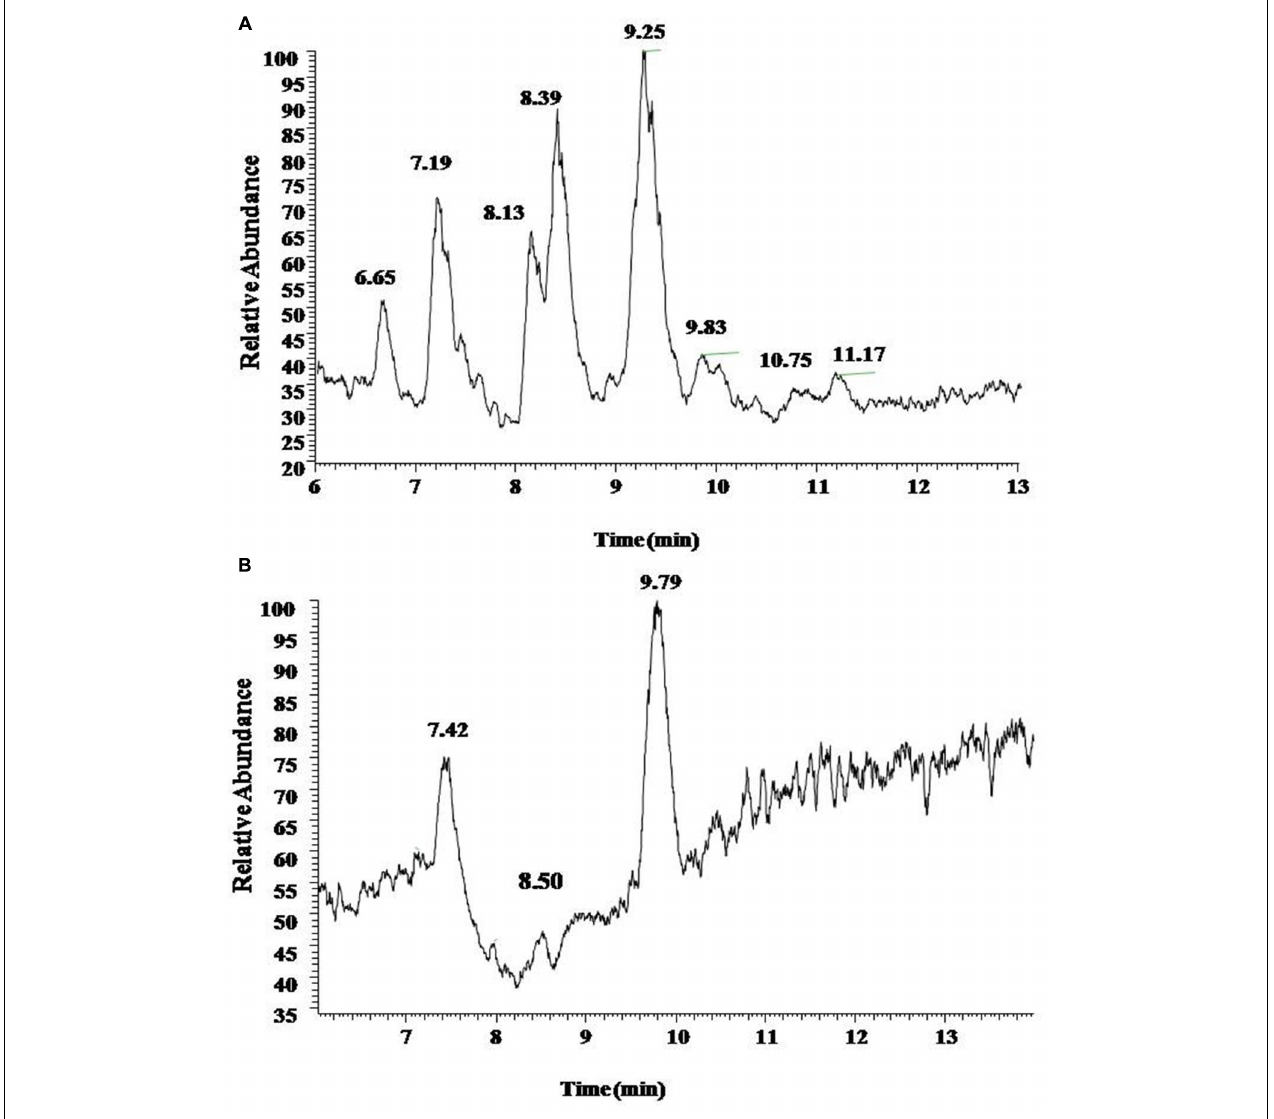
FIGURE 2 | The UV chromatogram of reference standards (A) and sample (B) . Both reference standards and sample displayed Peak A at retention time 7.5 min, Peaks B and C at 8.5 and 9.5